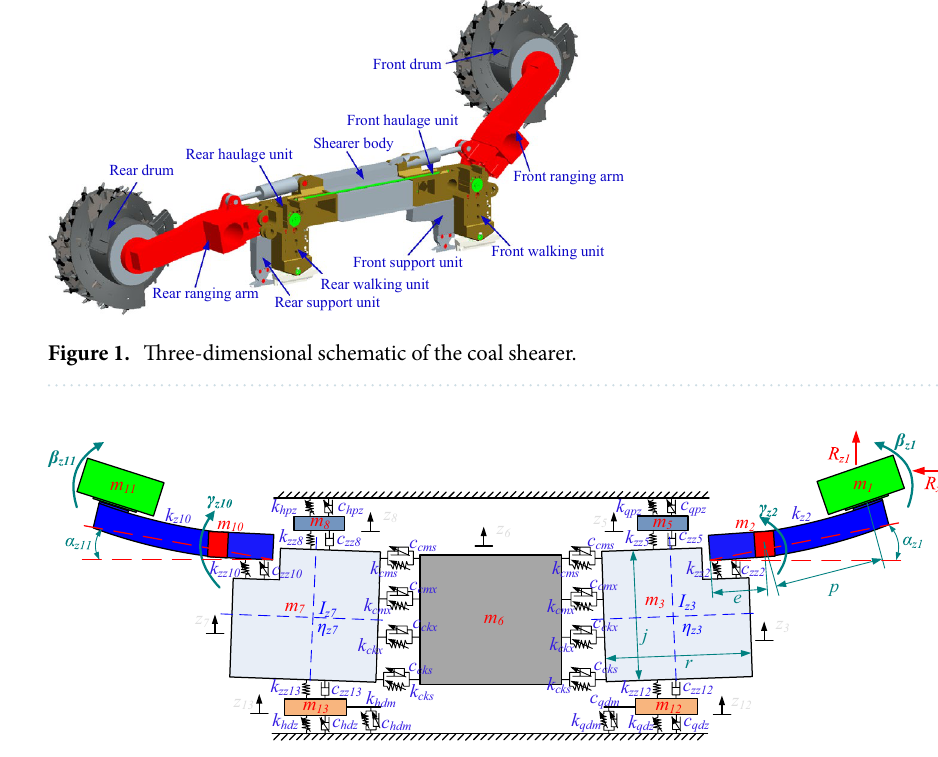
Figure 2. Non-linear dynamics model of a coal shearer under slant-cutting